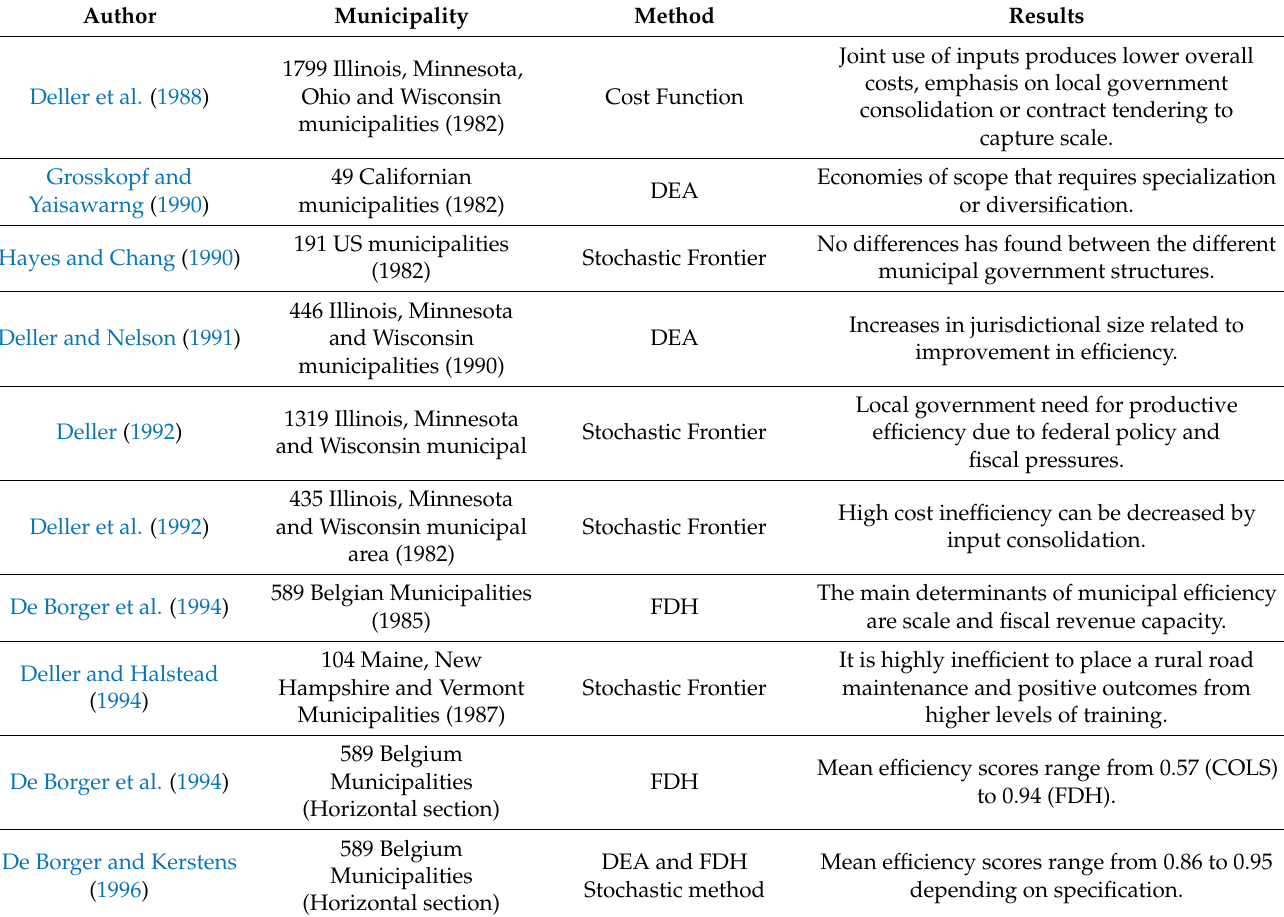
Table 1. Previous studies on local